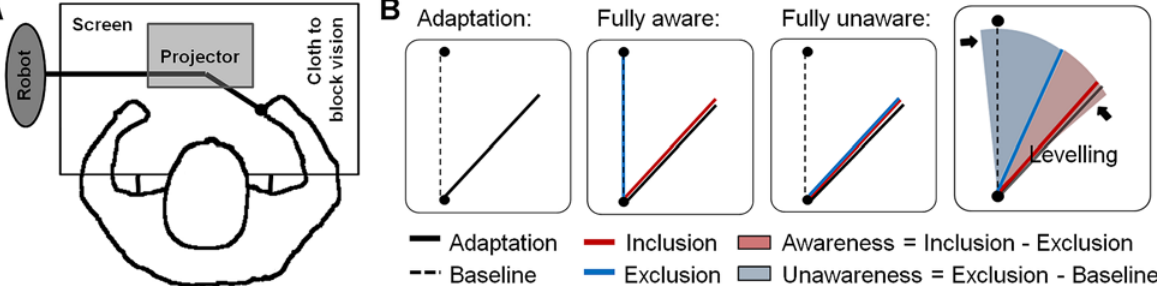
Fig 1. Scheme of experimental apparatus (A). Shown are robot, display screen and projector. Measuring awareness and unawareness (B). Exemplary adaptation, inclusion and exclusion movement directions indicating fully aware or unaware behaviour. Schematic and simplified presentation of awareness and unawareness. Note that for calculation of an awareness and unawareness index normalized mean movement directions of inclusion and exclusion were used in order to allow comparison between rotation angles (see Methods). Movement directions were levelled between baseline direction -10% and size of perturbation +10% as indicated by the